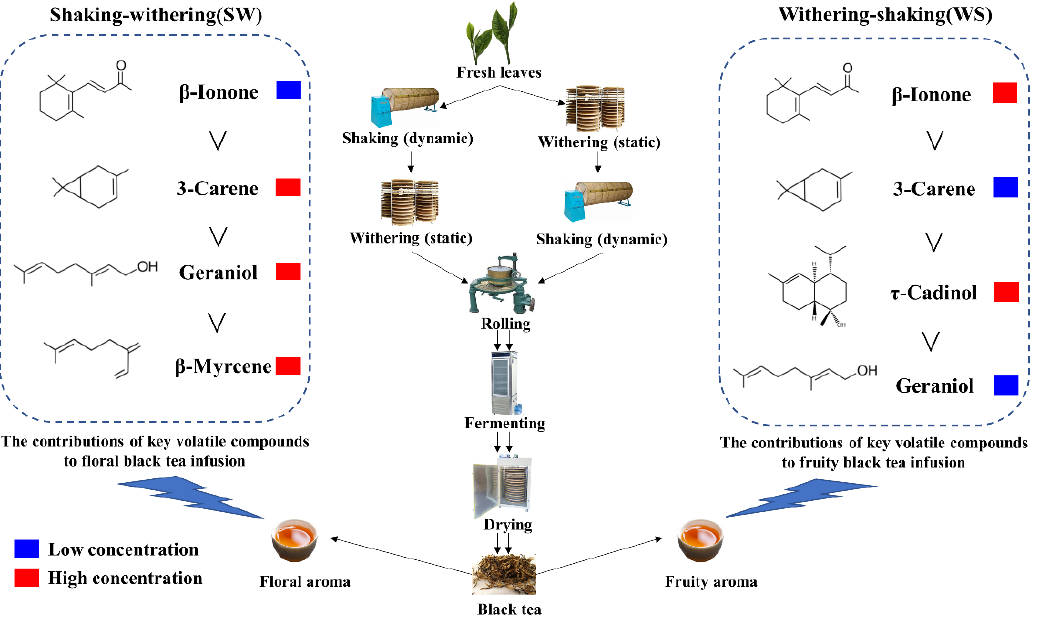
Figure 6. Schematic of experimental design and contribution of flavor-related volatile compounds to floral and fruity black teas.